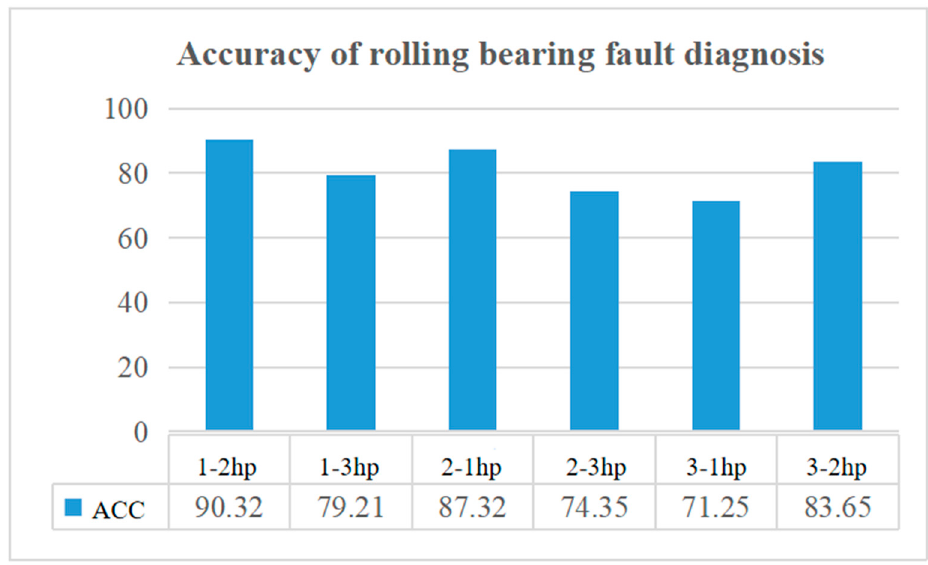
Figure 17. Fault diagnosis performance of rolling bearings under variable loads.